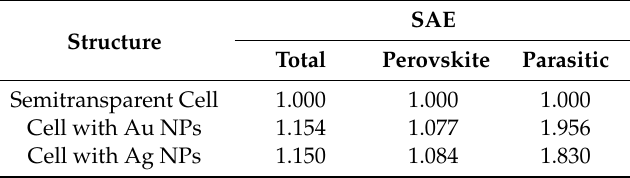
Table 5. SAE data for the three di ff erent cell